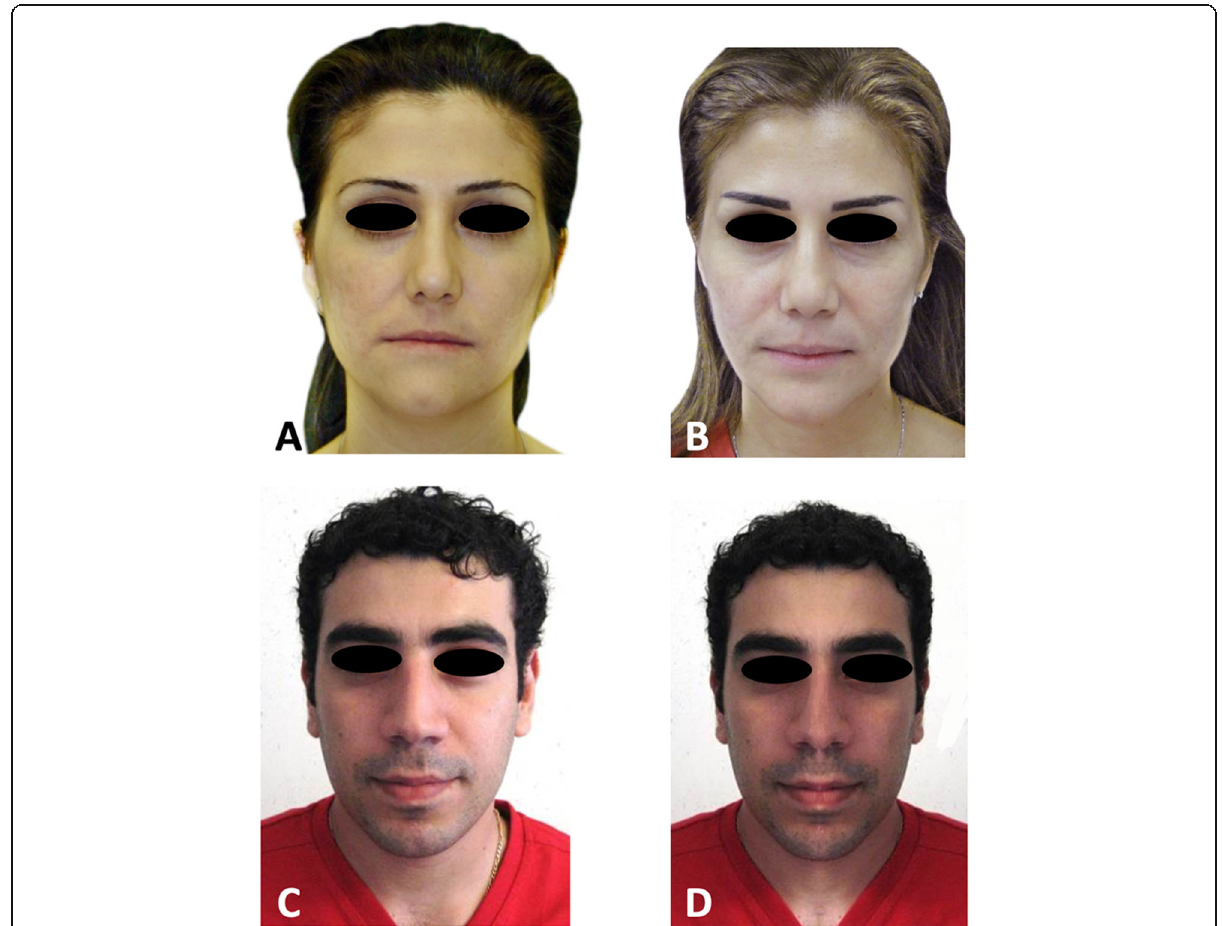
Fig. 1 Frontal photographs of patients used for the panel study. a Pre-surgical photograph of patient with a facial skeletal asymmetry. b Postsurgical photograph of patient after USSO correction. c Photograph of patient judged to have well-balanced facial proportions. d Mirrored photograph of patient where the right half of the face is